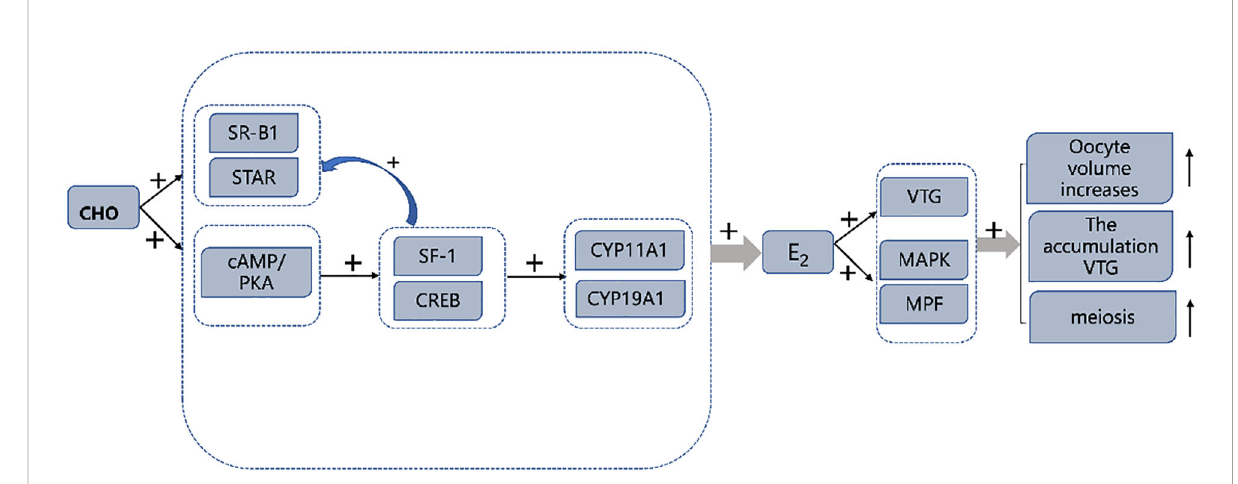
FIGURE 8 Graphical summary of CHO promotes ovarian maturation in Eriocheir sinensis . “ + ” symbol: expression was up-regulated by